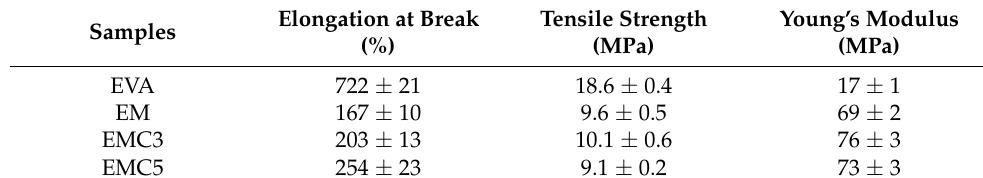
Table 8. Tensile test results of the composites.